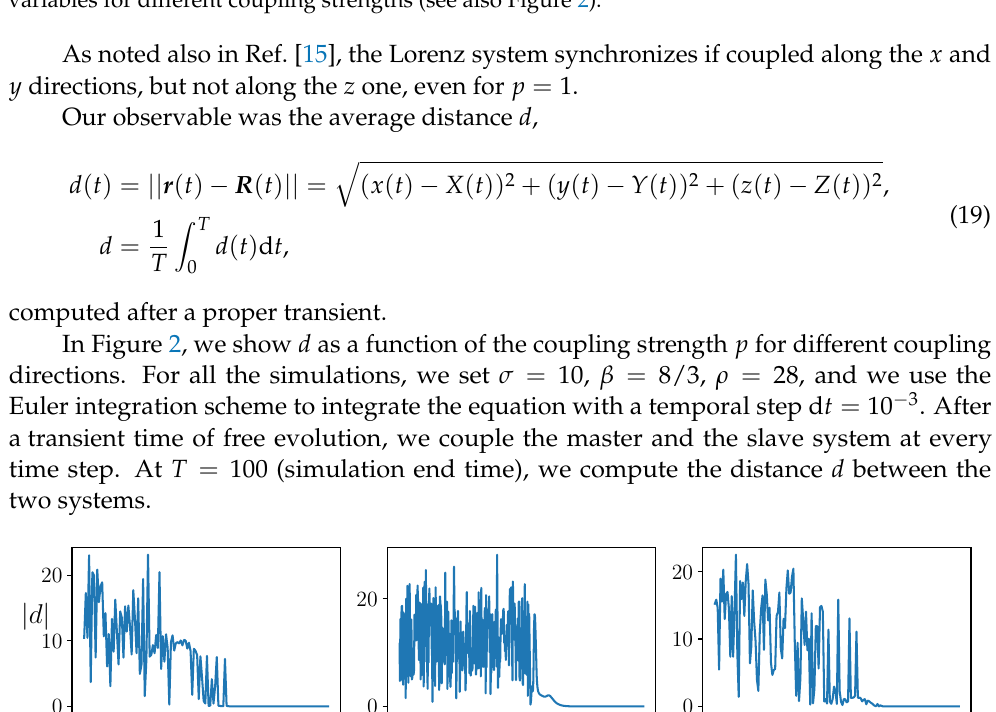
Figure 1. Conditional Lyapunov maximal exponent for different coupling directions: C x = [ 1,0,0 ] , C y = [ 0,1,0 ] , C z = [ 0,0,1 ] . The black dotted lined marks the zero value while the blue continuous line marks the value of the Lyapunov exponent. In the last one, in orange, we also show the distance d (normalized at its maximum value obtained in the simulation) between the master and slave state variables for different coupling strengths (see also Figure 2).